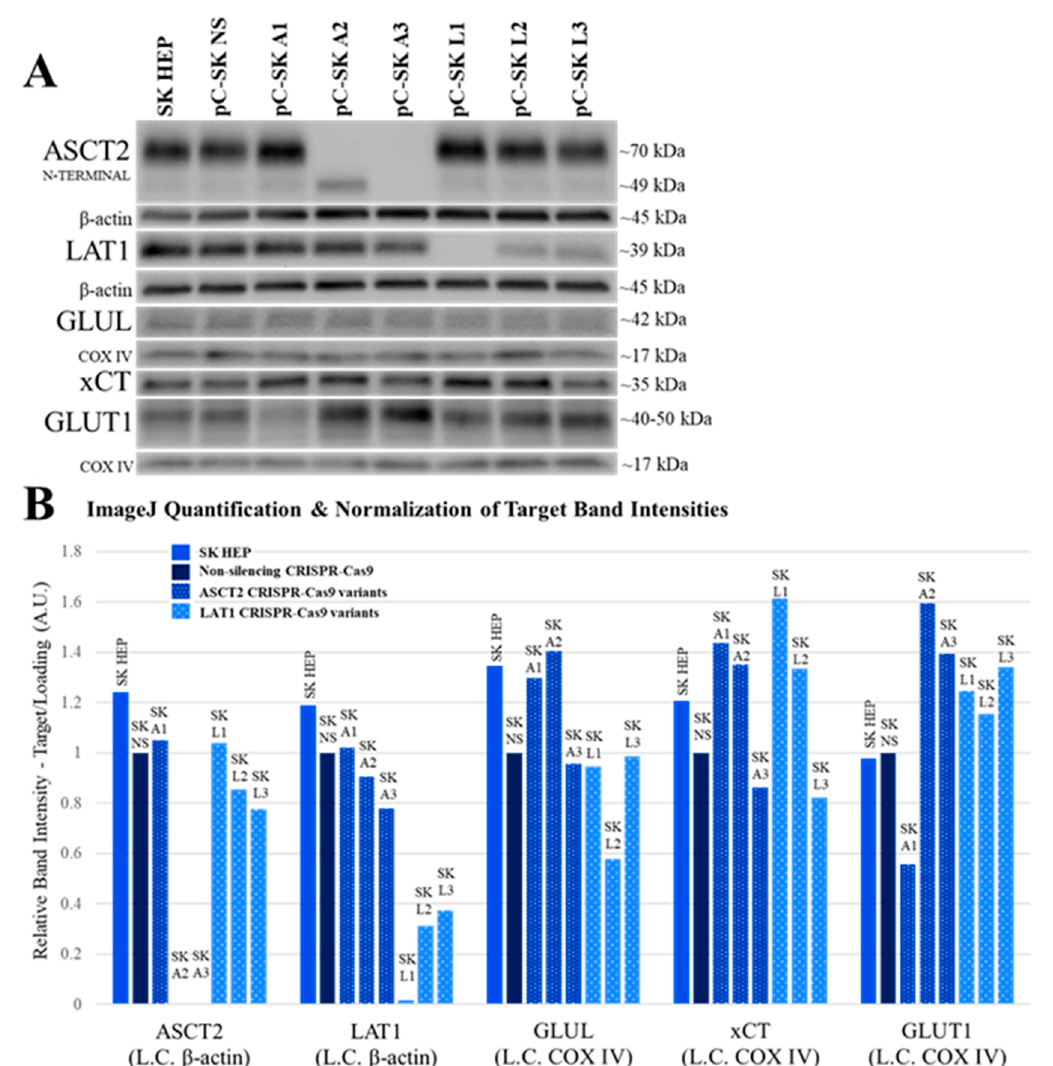
Figure 2. ASCT2, LAT1, GLUL, xCT, and GLUT1 protein in SKHep cell lines targeted for gene knockout with CRISPR-Cas9. Protein expression was measured by Western blot analysis as described in Materials and Methods. ( A ) The chemiluminescent bands for each target (ASCT2, LAT1, GLUL, xCT, and GLUT1) are shown in comparison to β -actin or COXIV protein detected on the same blots to control for loading error. One image for COXIV is shown for both xCT and GLUT1 because these proteins were detected on the same blot; ( B ) the band intensity of each target was quantified using ImageJ analysis software and normalized loading control (L.C.) band intensity in each lane.